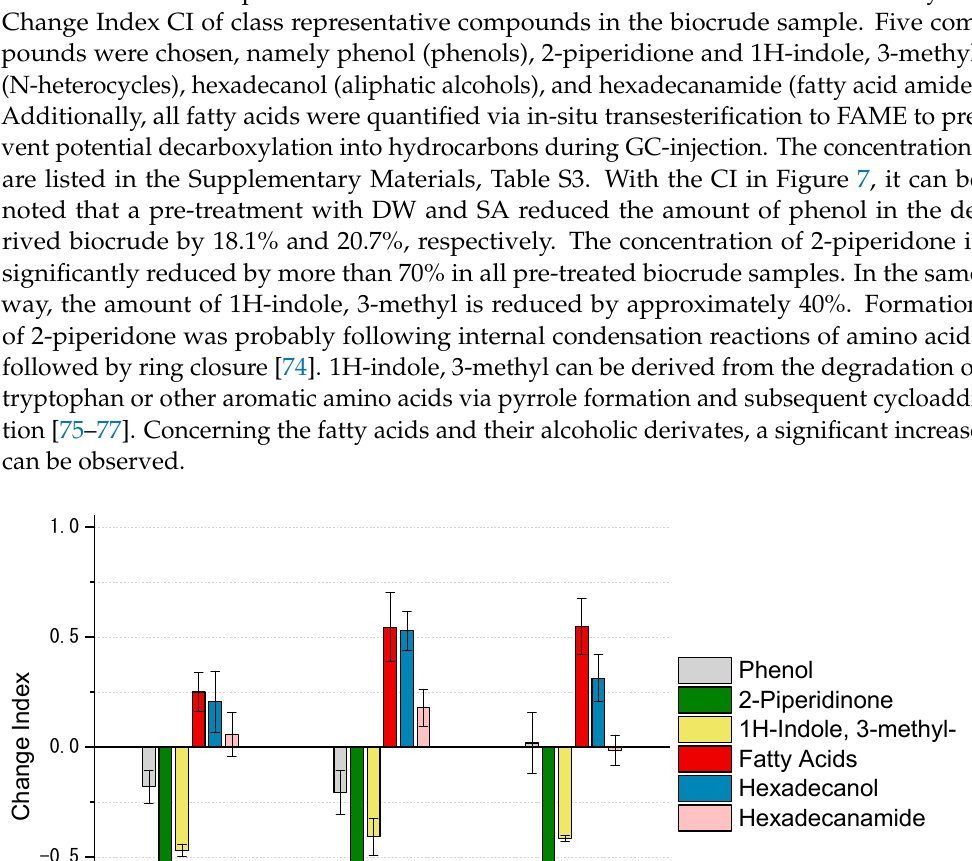
Figure 7. Change indexes (CI) of selected compounds in biocrude derived by hydrothermal liquefac- tion of pre-treated solids (indexes were calculated based on the comparison to the untreated product). DW-HTL and derived biocrude show a 25% increased content of free fatty acids, which can be further increased by more than 50% by acid pre-treatment. For hexadecanol, a hydrodeoxygenation product of hexadecanoic acid, the concentration is increased by 20.6% for DW-HTL and by 31.3% for CA-HTL. The highest increase of 52.9% was observed for SA-HTL. The content of hexadecane amide is slightly and non-significantly increased in DW-HTL biocrude. SA-HTL sample shows the highest increase of 17.9% of hexade- canamide. As acidic residuals in the SA-Solid are assumed, the pH is lowered during HTL, close to neutral. Referring to Fu et. al., the formation of amides is decreased under